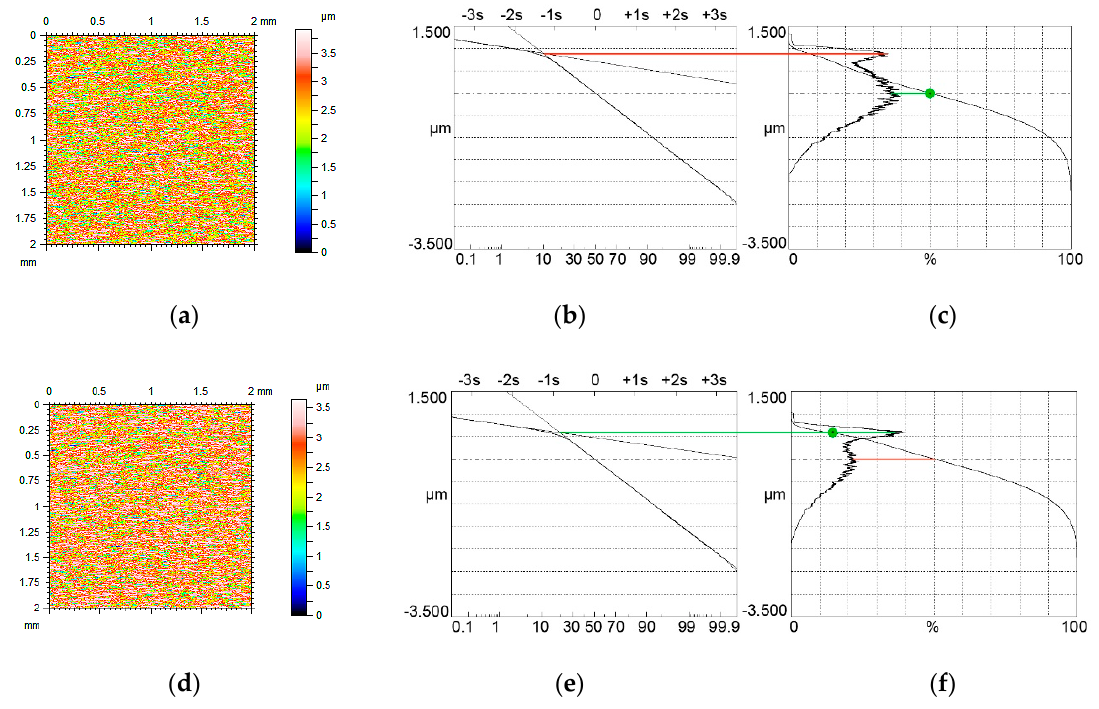
Figure 5. Contour plots ( a , d ) surface probability plot ( b , e ), material ratio curve and probability distribution ( c , f ) of two-process isotropic modeled surfaces of the Smq parameter of 10% ( a – c ) and 20% ( d – f ), the other parameters of both surfaces are Spq = 0.12 µm, Svq = 0.7 µm, both surfaces have bimodal ordinate distributions.